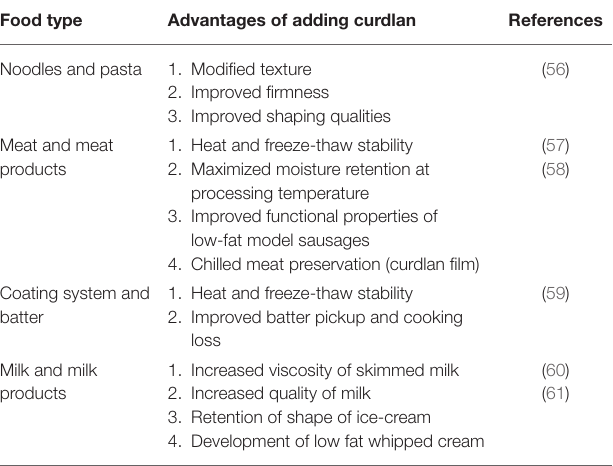
TABLE 3 | Advantages of adding curdlan in foods and dairy